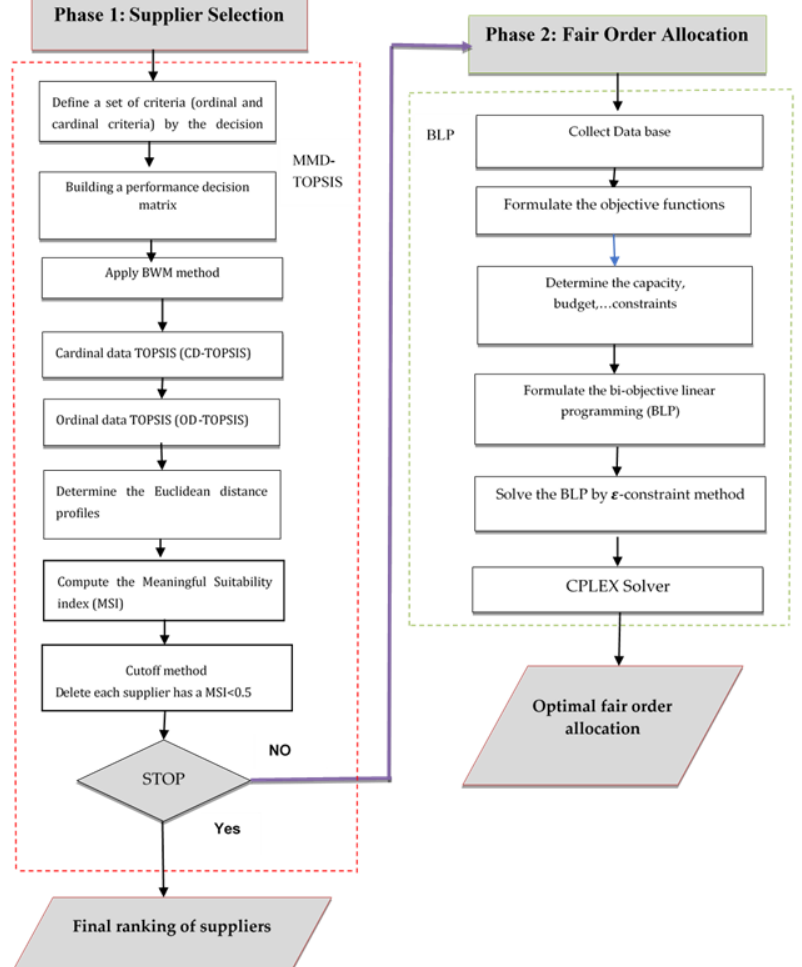
Figure 2. The hybrid integrated